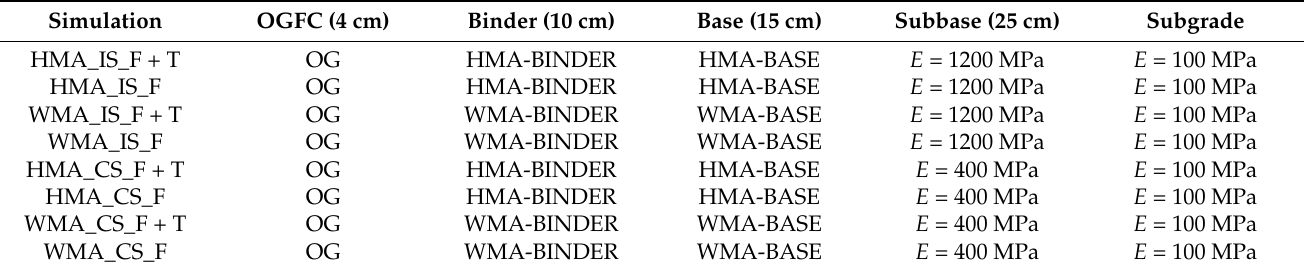
Table 4. Material properties considered in the FlexPAVE simulations.